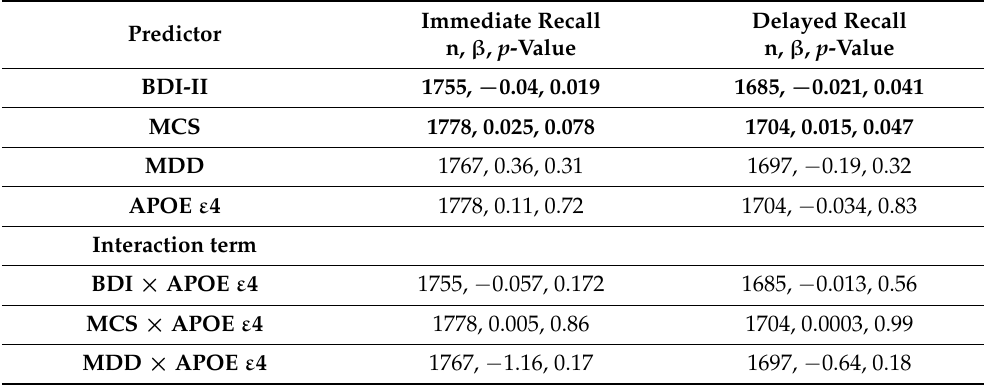
Table 5. Direct effects and interaction results for depression variables and APOE4 status on the endpoint verbal memory (VLMT) in LEGEND for covariate set